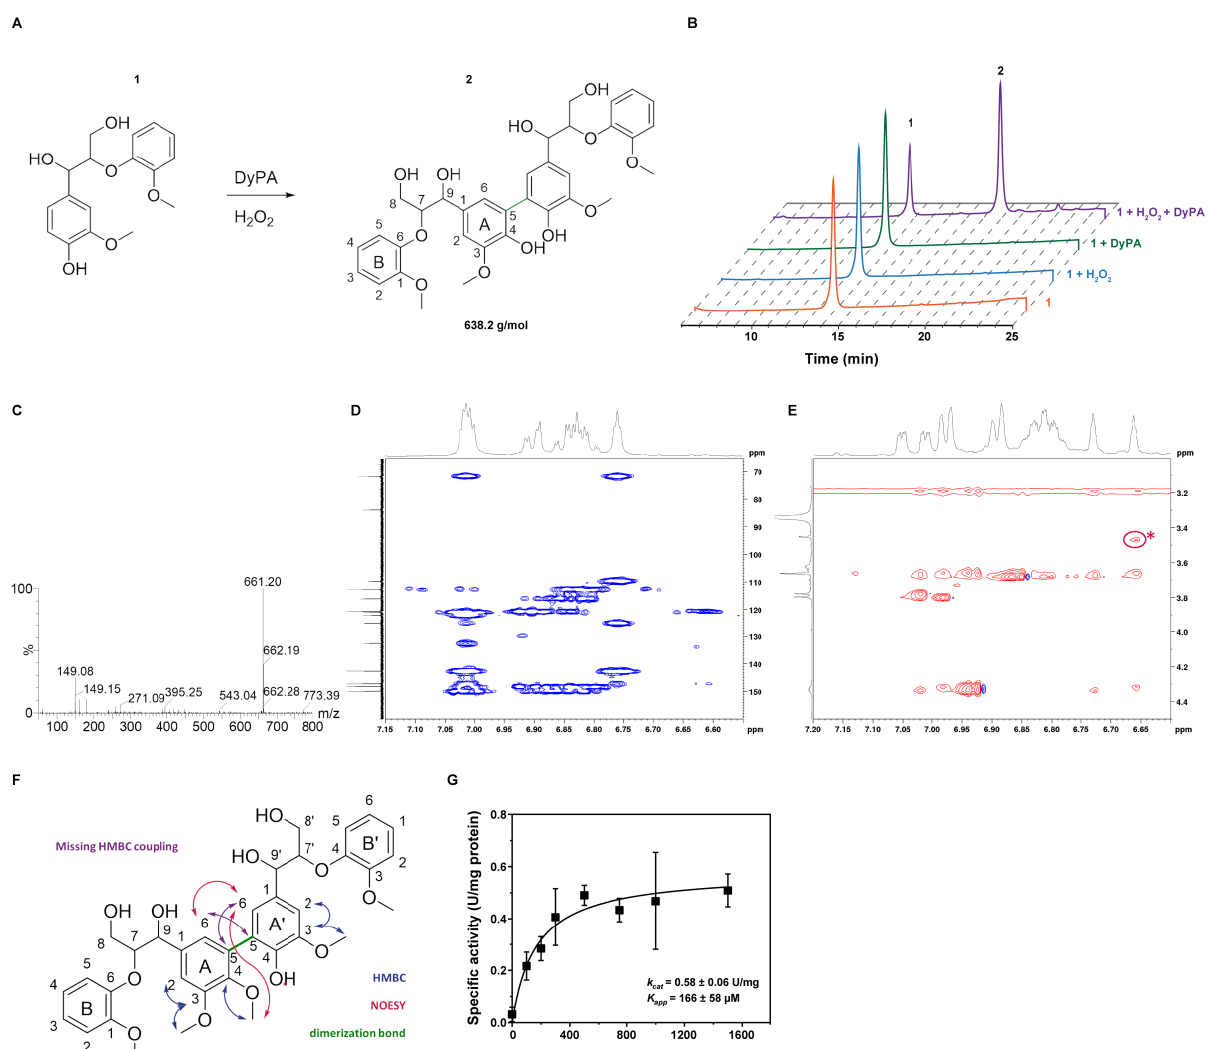
Figure 5. Oxidation of lignin model substrate (GGBGE) by Dictyostelium DyPA. ( A ) Structure of the ß-aryl ether lignin model substrate ( 1 ) and the proposed dimeric product ( 2 ). ( B ) Reverse HPLC profiles monitoring substrate turnover in the absence and presence of DyPA and H 2 O 2 . ( C ) ESI-MS of 2nd HPLC peak with an experimental m/z value of 661.20 for the Na adduct of ( 2 ). The calculated m/z value corresponds to 661.2261. ( D ) The structure of the catalyzed dimerization of GGBGE by Dictyostelium DyPA is demonstrated by a 2D HMBC experiment. This spectrum shows the proposed structure, in particular the coupling of H15 (=6.77 ppm) to A5 (=125.9 ppm). However, due to the fact that it is a symmetrical molecule, the ring systems A and A ′ cannot be clearly distinguished. ( E ) The structural elucidation of the asymmetric methoxy derivative is based on NOE spectroscopy. The spectrum shows the introduced interaction between the methoxy group (d = 3.45 ppm) and C15*-H (d = 6.66 ppm), marked with a star. ( F ) The coupling scheme of GGBGE of the HMBC (blue arrows) and NOESY (red arrows) experiments. The green bond indicates the dimerization bond as the result of the Dictyostelium DyPA mediated dimerization. The blue methoxy group is introduced by derivatization to create the asymmetry; the NOE-signal of this asymmetry is indicated by a red star. The purple arrows indicate missing HMBC couplings for the methoxy derivative. ( G ) Oxidation of veratryl alcohol by Dictyostelium DyPA. Each data point corresponds to the averaged values from 3–6 independent measurements. Error bars represent the standard deviations.